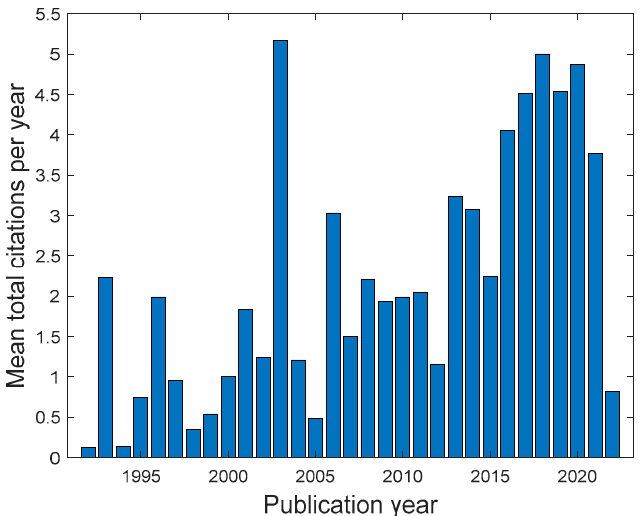
Figure 5. Temporal evolution of mean total citations per year in CBD_NDT research from 1992 to 2022 .